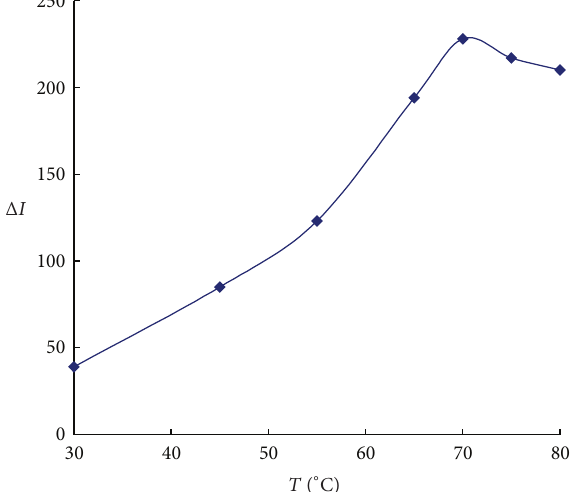
F 6: Effect of reaction temperature.